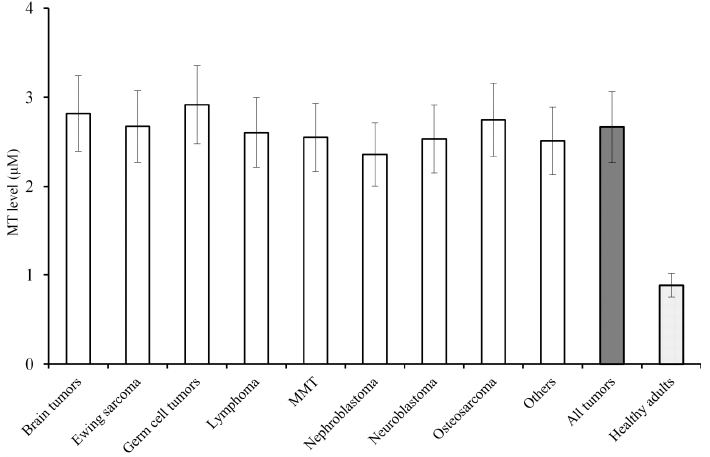
Figure 1. MT level/mean ± s.d./in different childhood malignant tumours. Hatched column: all tumours; doted columns: healthy adult volunteers. There were no statistically significant differences between different tumours, difference between MT levels in all malignant tumours and in healthy volunteers was significant. MMT: Soft tissue sarcoma (Malignant mesenchymal tumours).